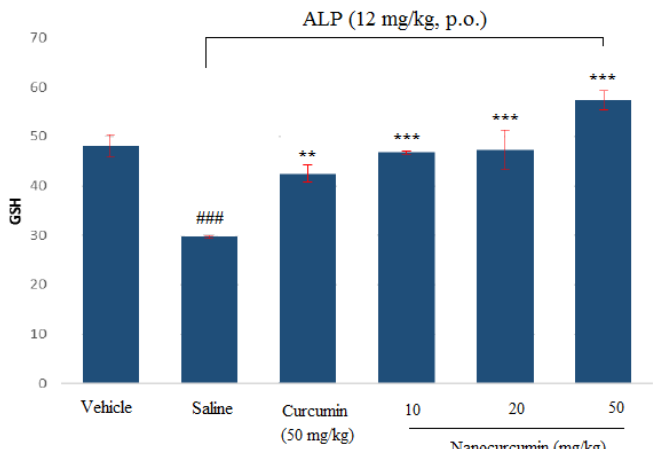
Fig. 6. Effects of curcumin and nanocurcumin on GSH levels in ALP-intoxicated rats. ### P<0.001 significantly different from vehicle. **P<0.01 and ***P<0.001 significantly different from control group (ALP + saline).